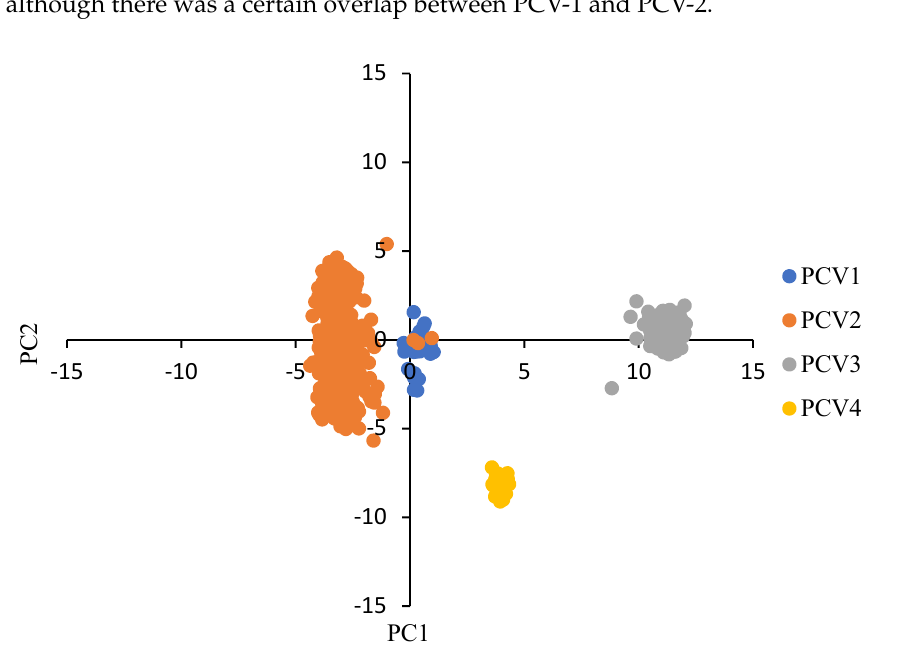
Figure 1. PCA of all selected PCVs based on the ORF12 RSCU values. PCV strains are plotted based on the first two principal components (PC) values. Each point represented one PCV strain. PCV ‐ 1, PCV ‐ 2, PCV ‐ 3 and PCV ‐ 4 were represented in blue, orange, grey and yellow, respectively.